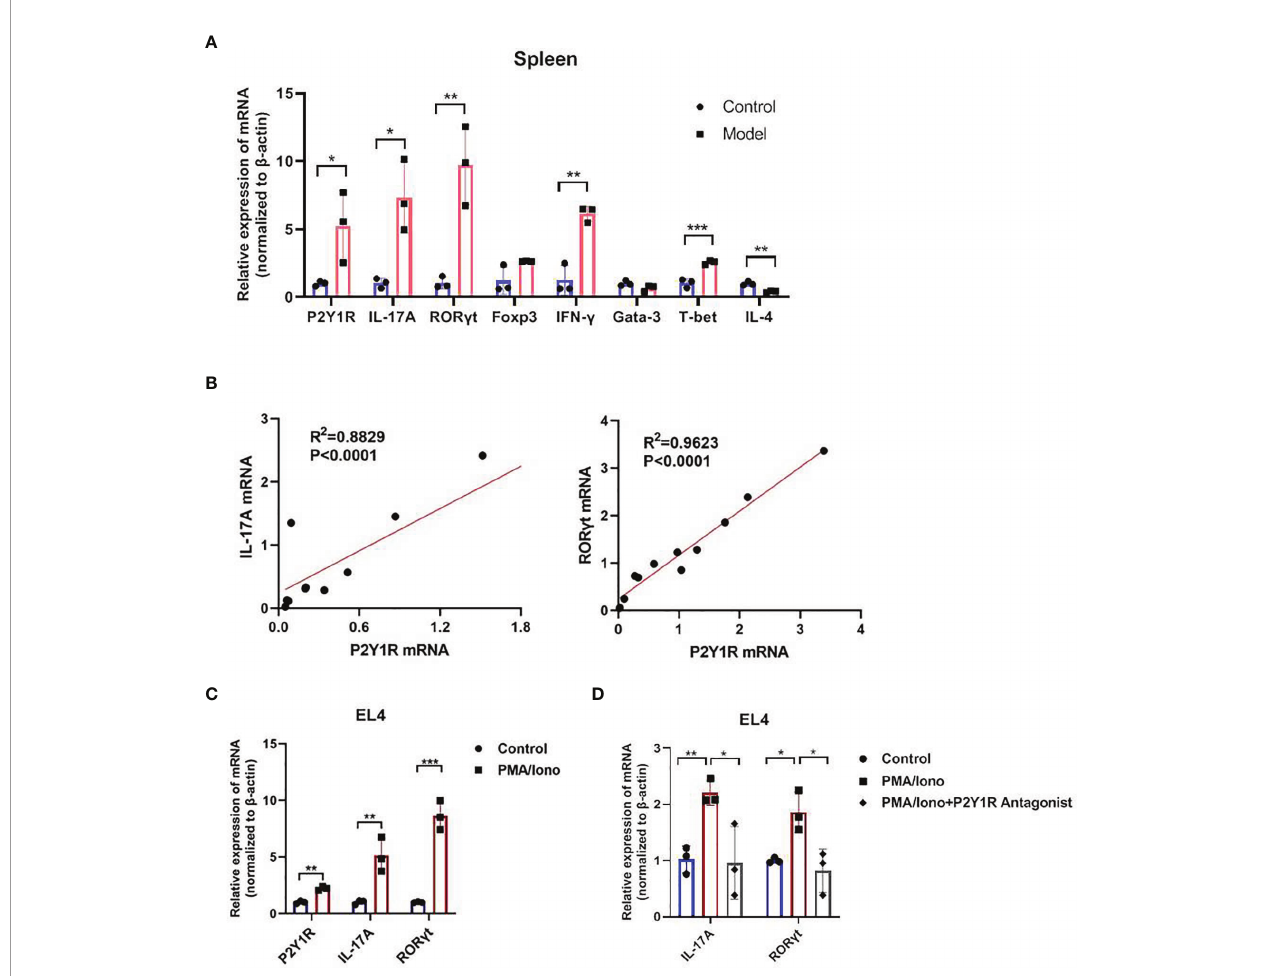
FIGURE 1 | Increased P2Y1R is positively associated with Th17 response. (A) mRNA expression of P2Y1R, IL-17A, ROR g t, Foxp3, T-bet, INF- g , Gata-3 and IL-4 in the splenocytes of DSS-treated mice. Data are expressed as mean ± SEM (n=3). Compared to control mice, *p < 0.05, **p < 0.01 and ***p < 0.001. (B) Linear correlation analysis between transcripts of P2Y1R and IL-17A, ROR g t in the splenocytes of DSS-treated mice (n=11). (C) mRNA expression of P2Y1R, IL-17A, ROR g t in EL4 cells treated with PMA and ionomycin. (D) Antagonistic effect of P2Y1R on the gene expression of IL-17A and ROR g t in EL4 cells treated with PMA and ionomycin. Data from EL4 cells are expressed as mean ± SEM of three independent